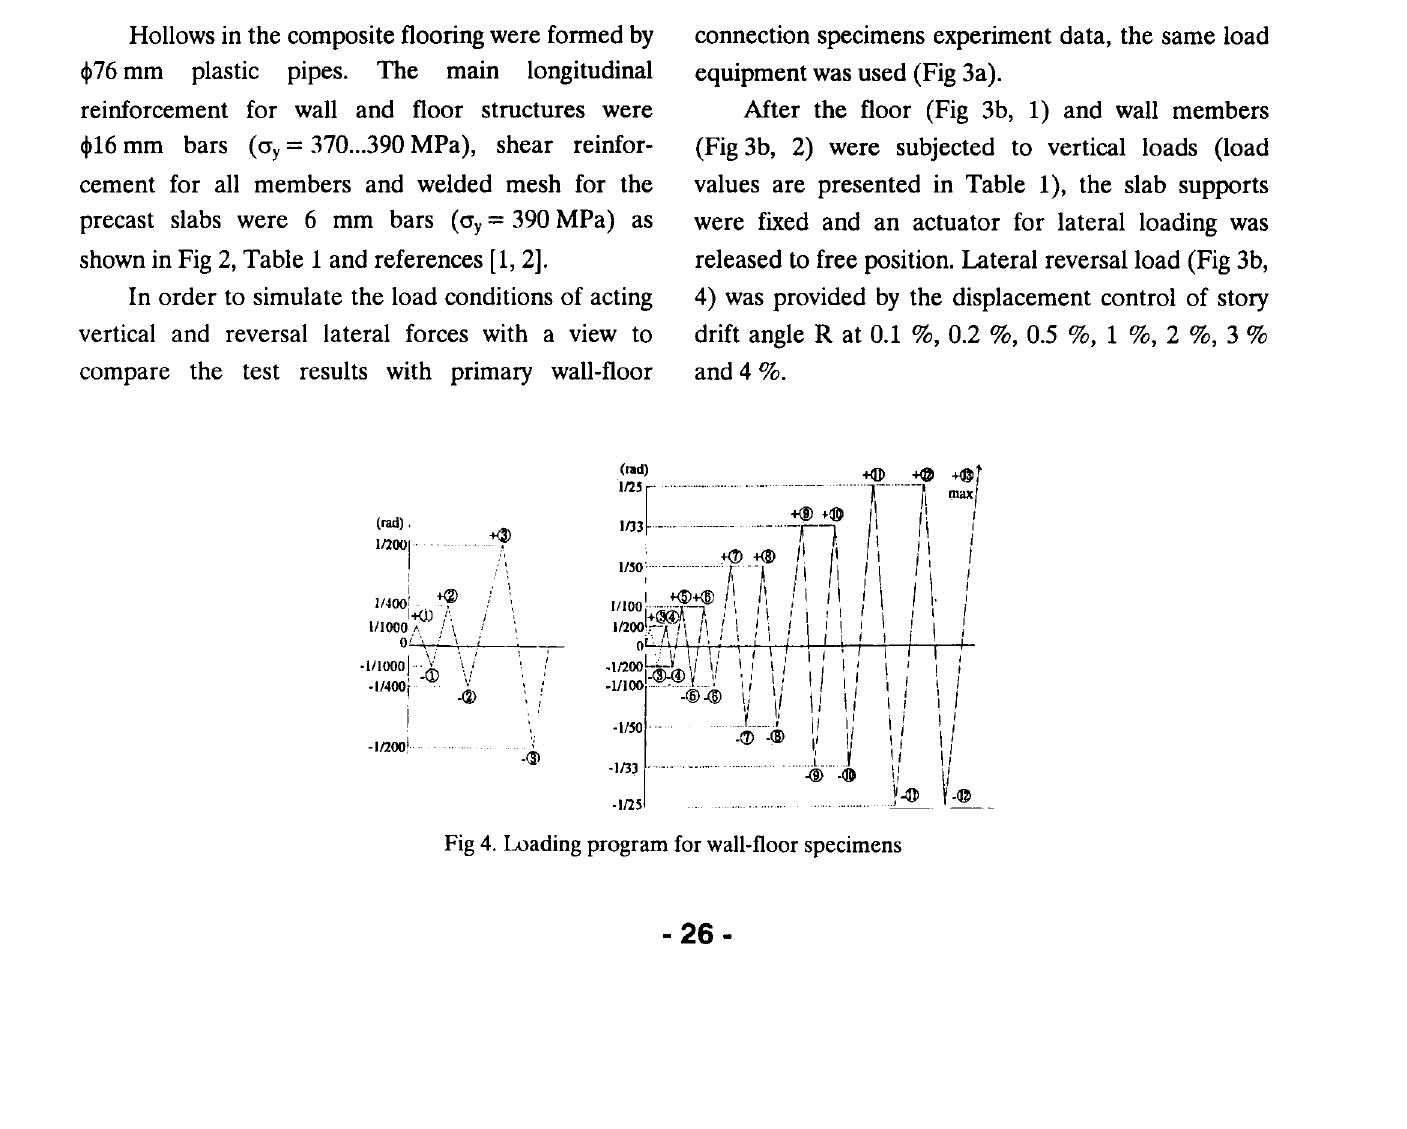
Fig 3. Equipment for vertical and reversal lateral loading of specimens (a) and their loading order (b)